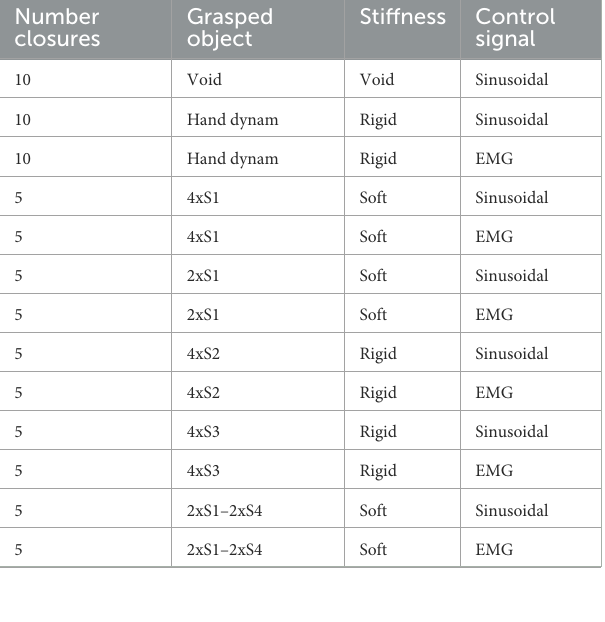
TABLE 2 Dataset realization for training the NLR for object stiffness recognition algorithm. Number closures